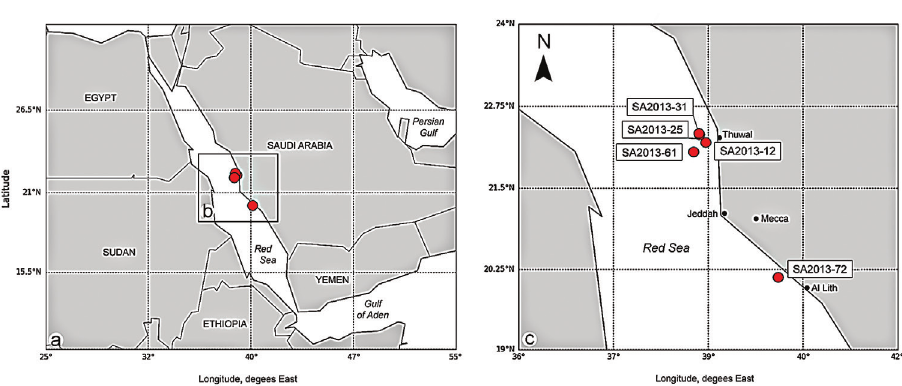
Figure 1. a–c Sampling localities and study area in the Red Sea (Saudi Arabia). The red circles indicate sampling localities of the indicated samples of Stylophora pistillata (see Table 1).